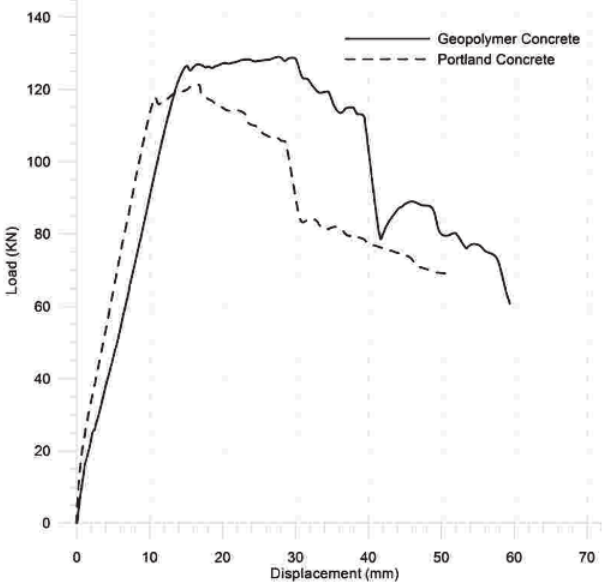
Figure 4 Load vs vertical displacement curves of the tested beams, obtained by using the LVDTs